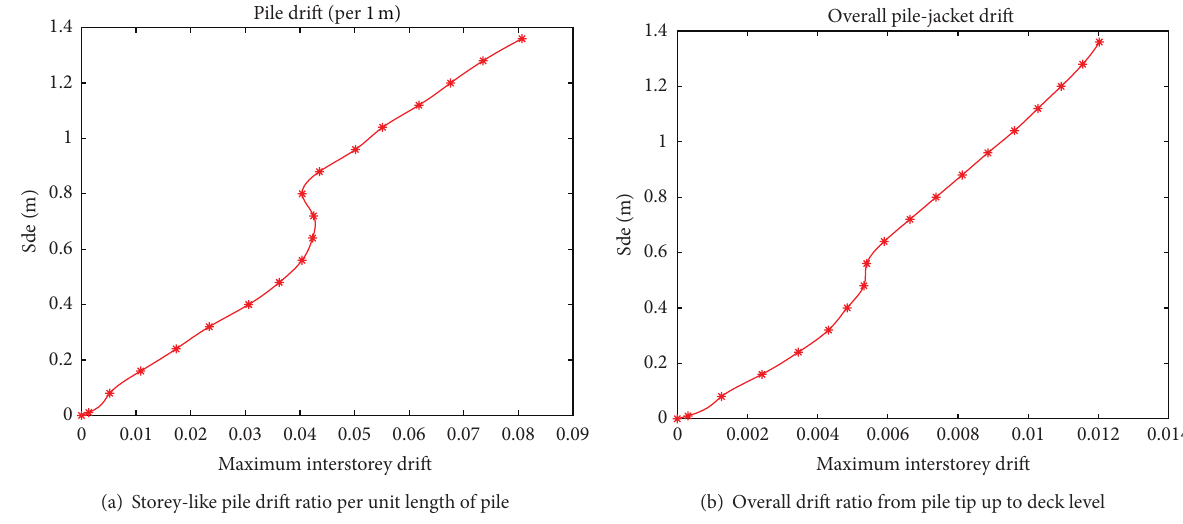
Figure 7: IDA curves of record number 17 for original platform.